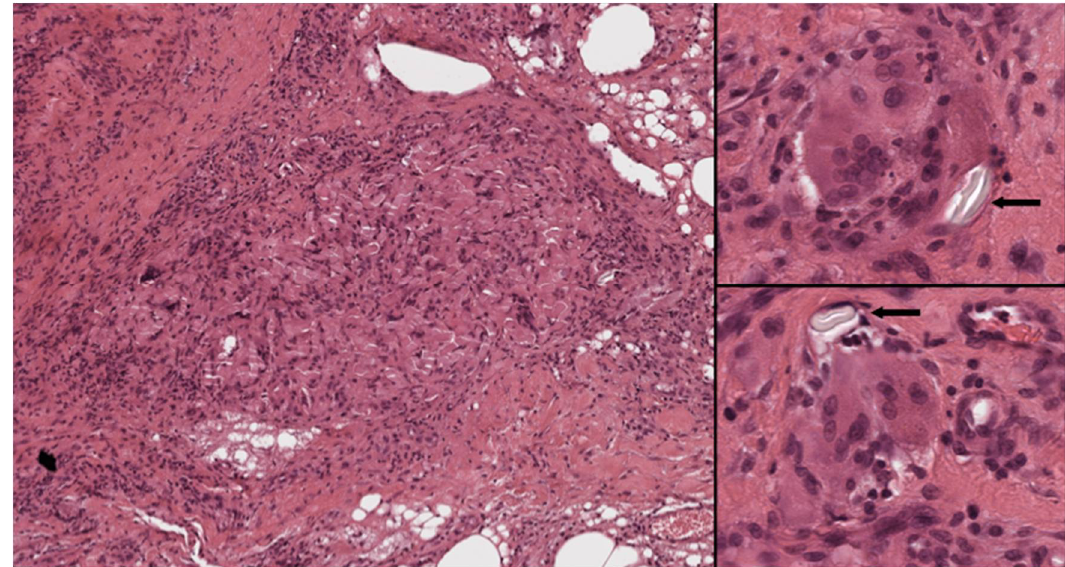
Figure 6. Foreign body reaction to suture material. Left: Histiocytes are deeply intermingled with the suture material. Right: Numerous foreign body-type giant cells are seen around inert material (arrows) (Left: H&E 40×; right, top and bottom: H&E